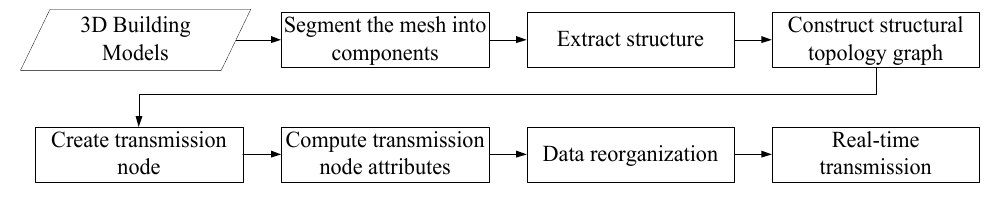
Figure 2. Algorithm flowchart.